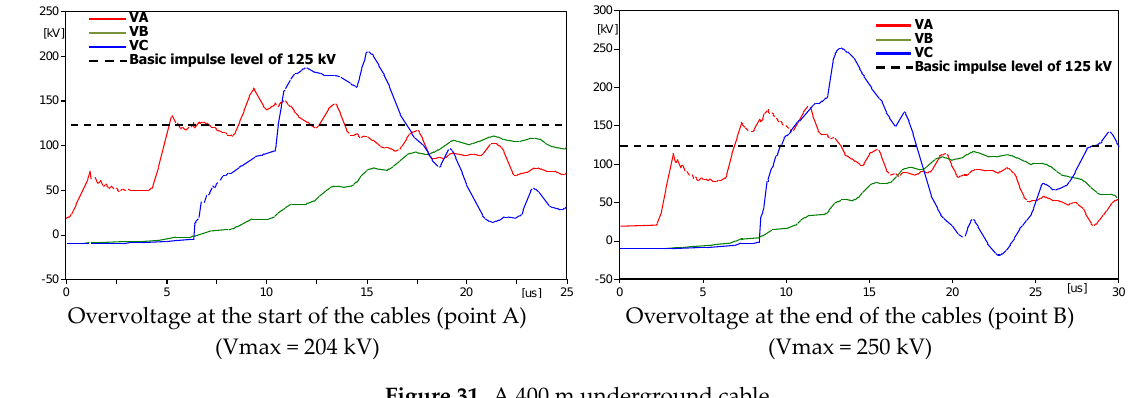
Figure 30. A 300 m underground cable.